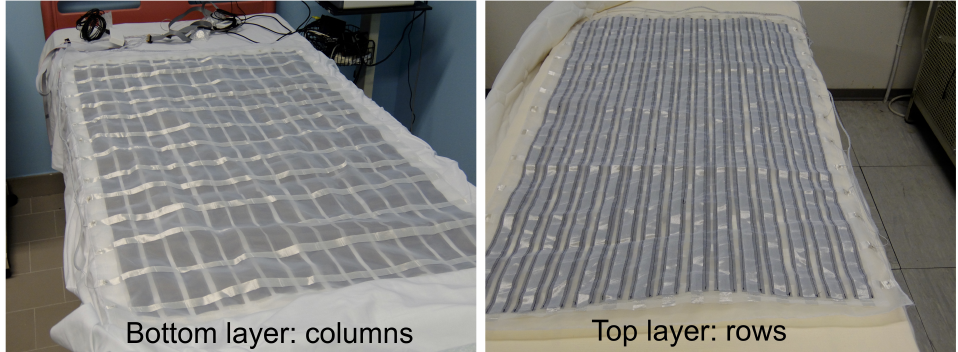
Figure 2. PML prototype: bottom layer (on the left ) and top layer (on the right ). In the top layer, it is possible to note the sliced piezoresistive layers aligned and centered with the row